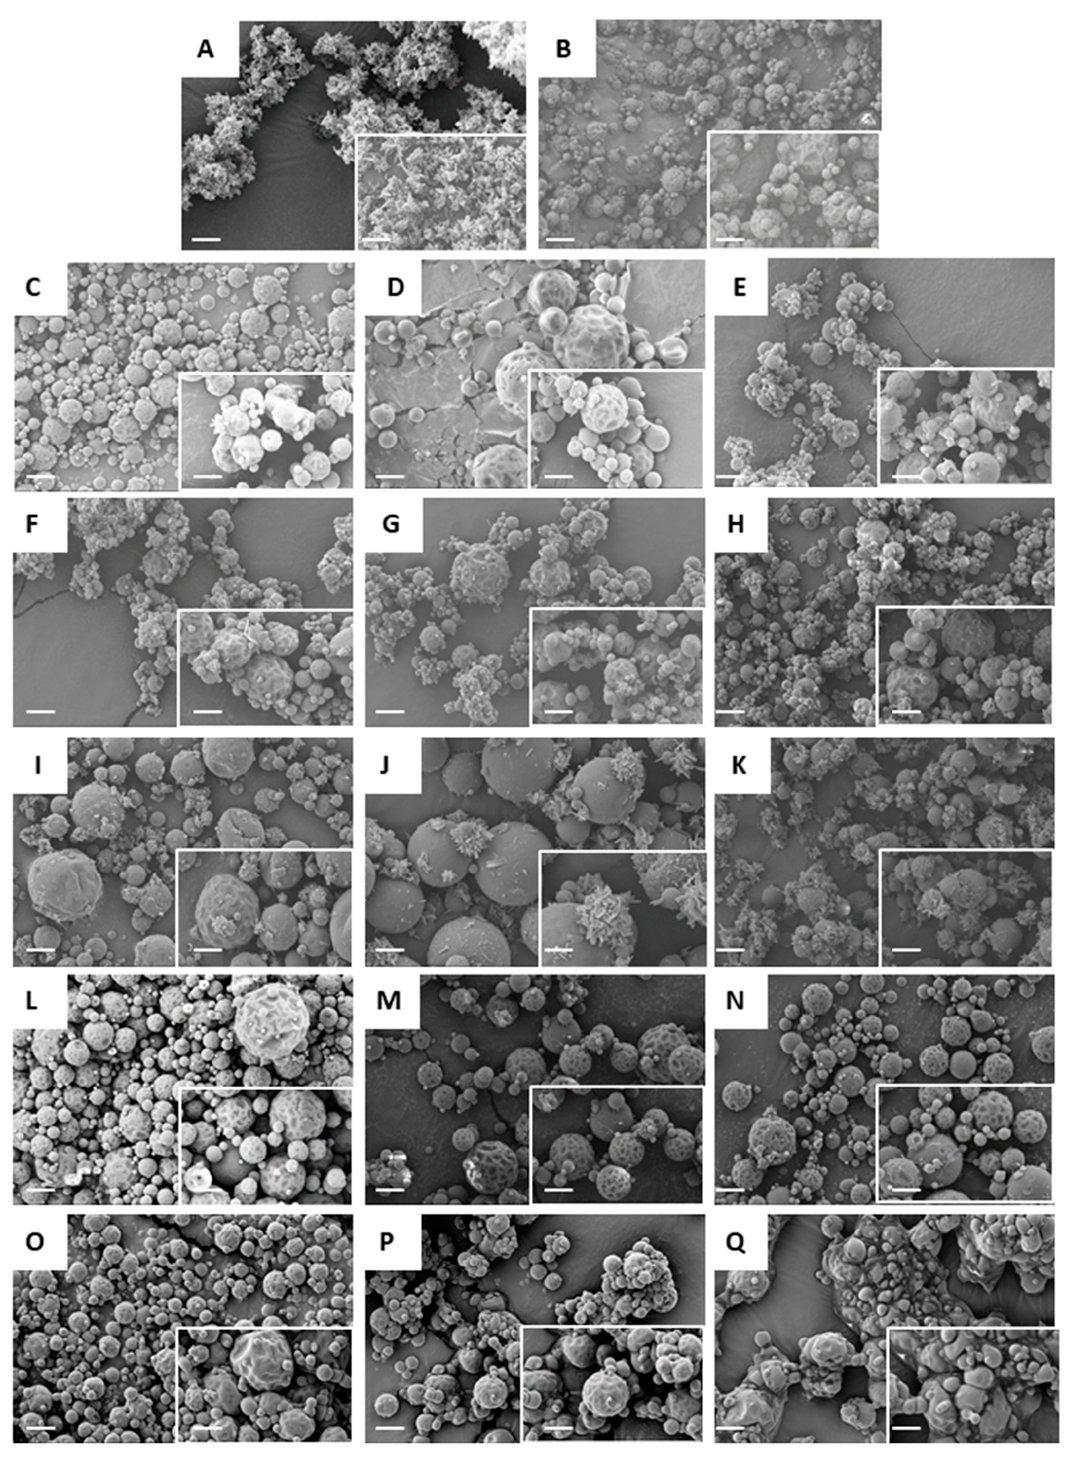
Figure 2. SEM images of the spray-dried formulations. ( A ) Spray-dried theophylline from water; ( B ) spray-dried salbutamol sulphate from water; ( C – N ) samples prepared using the three-fluid nozzle 3F_1-12 (as per Table 1); ( O – Q ) samples prepared using the two-fluid nozzle 2F_1-3 (as per Table 1). Bars correspond to 4 µm. Insert bars correspond to 2 µm.